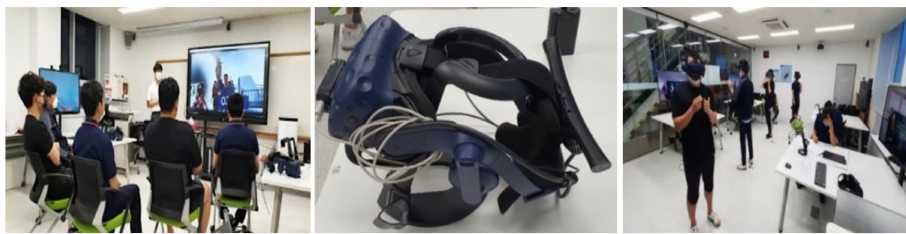
Figure 4. Video and VR training concept and VR equipment (HTC VIVE Pro